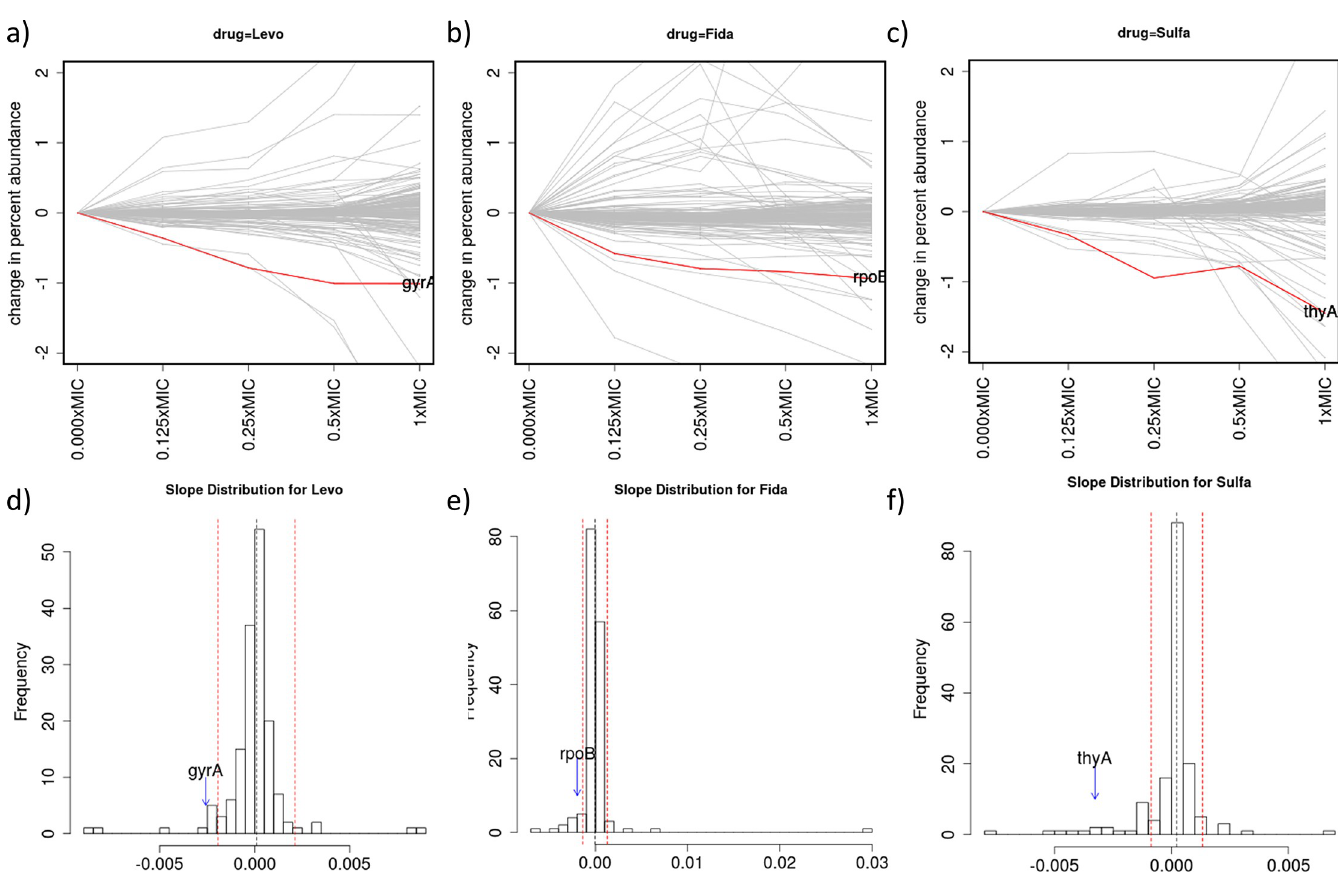
Fig 3. Analysis of chemical-genetic interactions with levofloxacin (Levo), fidaxomicin (Fida), and sulfamethoxazole (Sulfa). Abundance plots for all genes in the hypomorph library (a-c), and histograms of the distribution of slopes for each gene (d-f). gyrA , rpoB , and thyA clearly stand out as outliers for levofloxacin, fidaxomicin, and sulfamethoxazole,